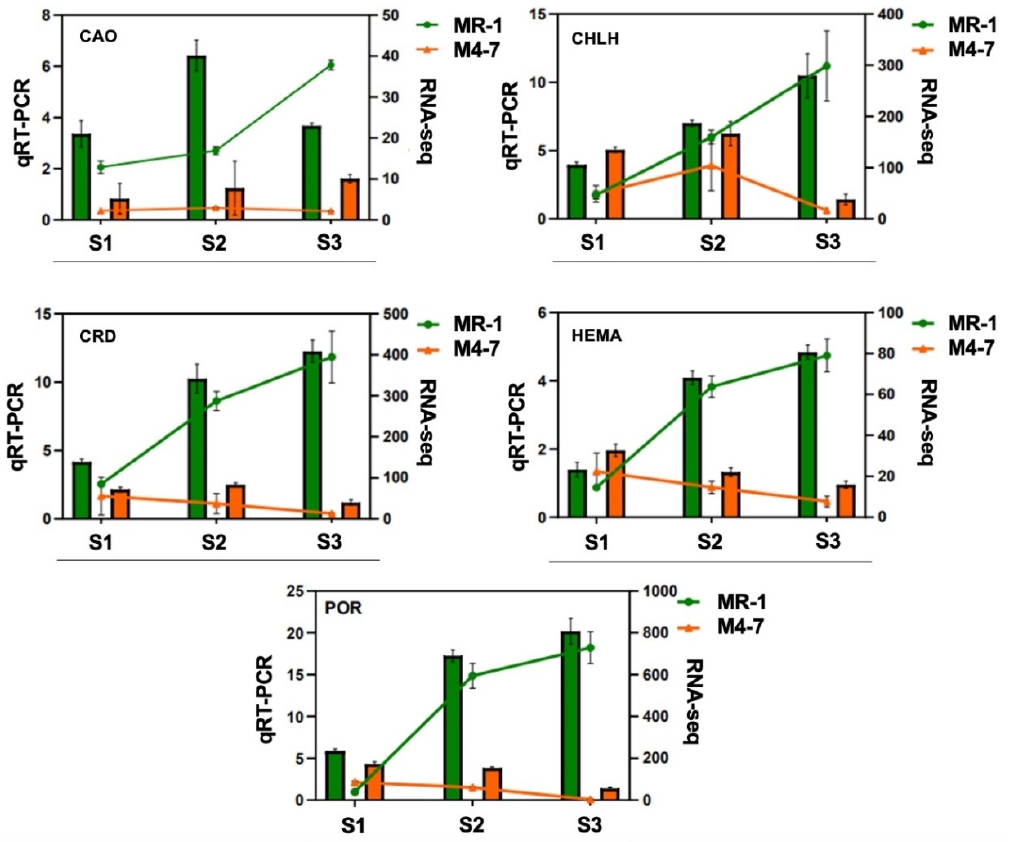
Figure 9. Different expression levels of five key genes of the chlorophyll synthesis pathway at different stages of stigma development in MR-1 and M4-7; bar graphs indicate qRT-PCR results and line graphs indicate RNAseq results. CAO : MELO03C010624 ; CHLH : MELO03C007233 ; CRD : MELO03C026802 ; HEMA : MELO03C011113 ; POR : MELO03C016714.